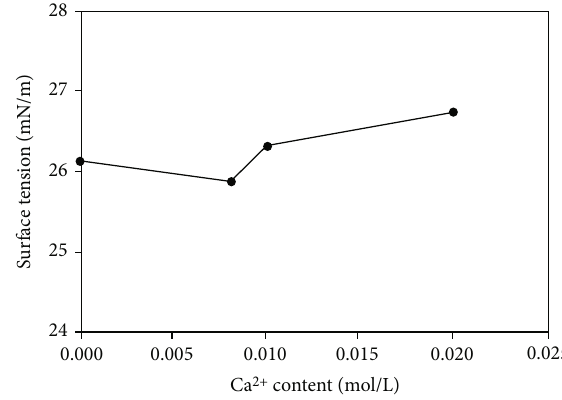
Figure 9: Relationship between Mg 2+ content and emulsion surface tension.